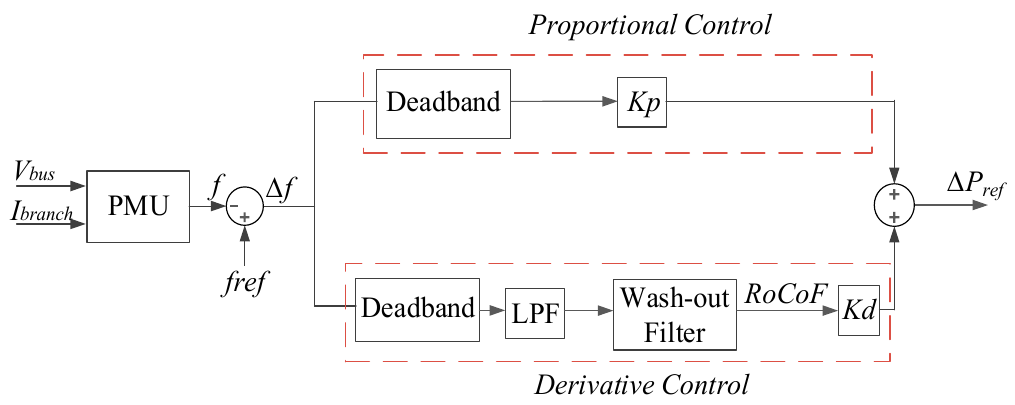
Figure 4. Combined droop- and derivative-based FAPR control.